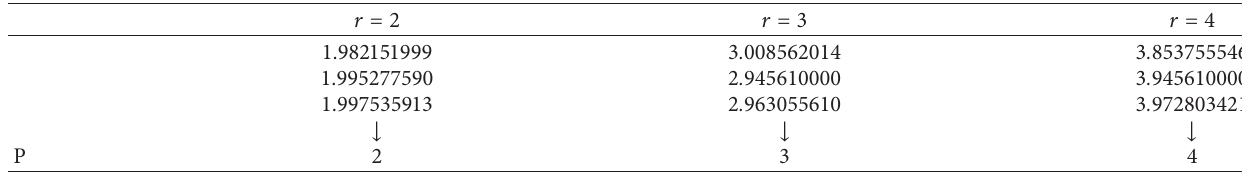
Table 7: Order of convergence for Example